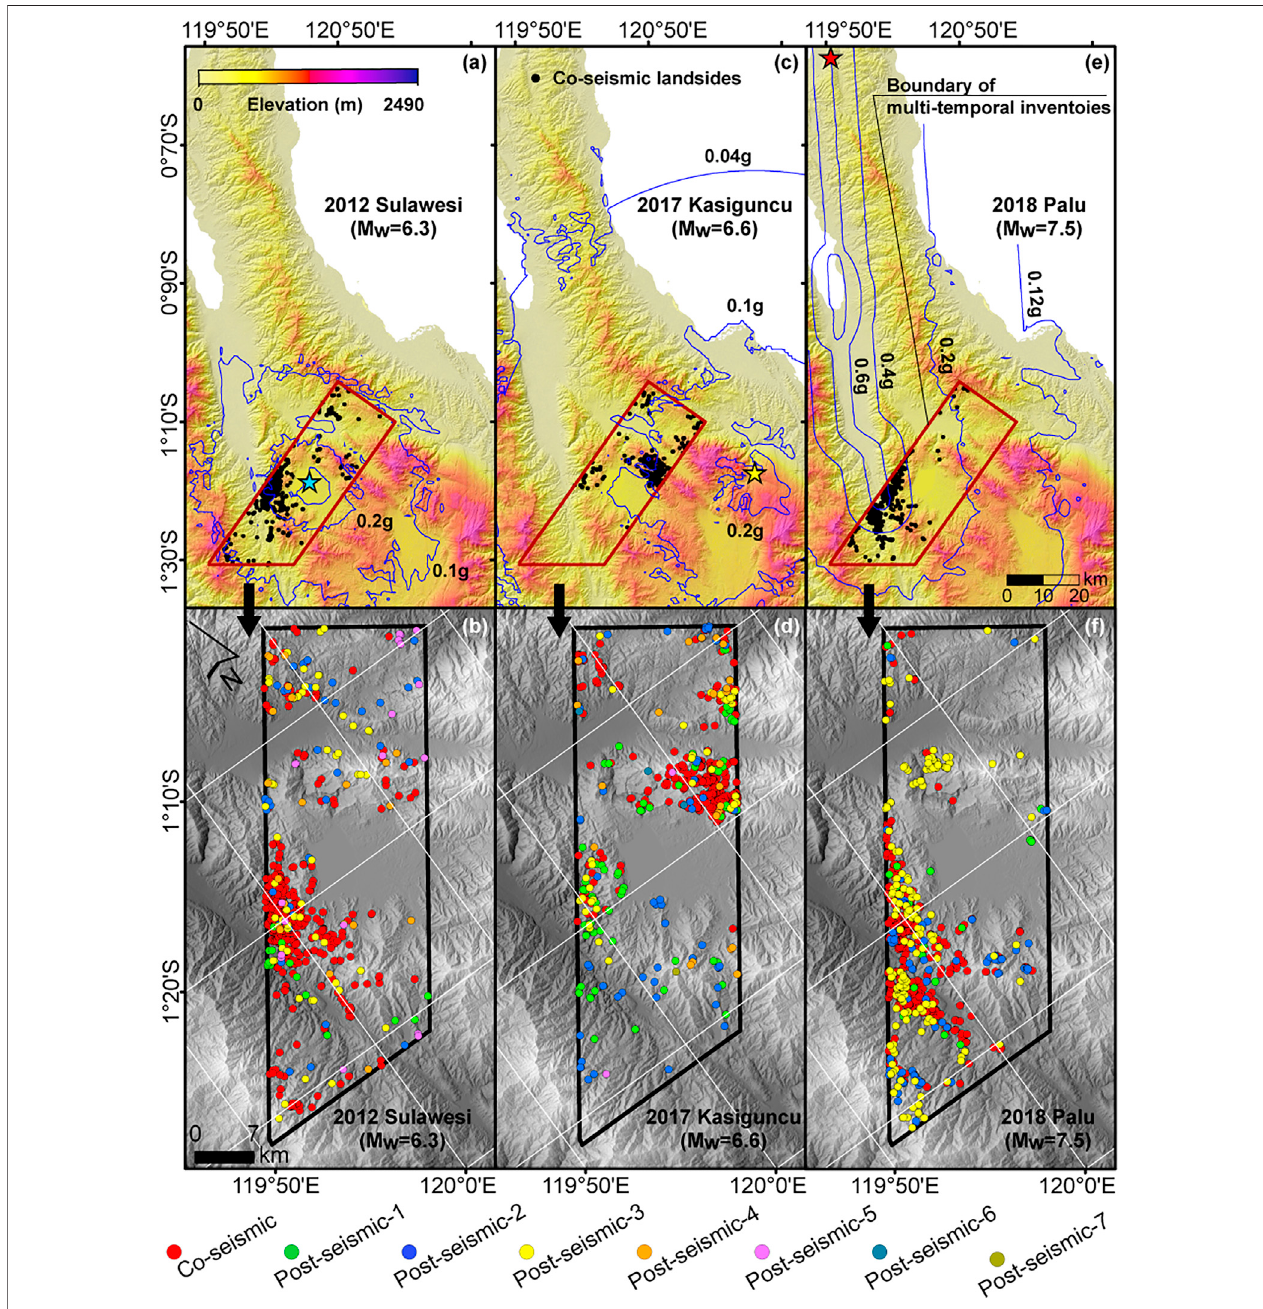
FIGURE4| Mapsshowingarealextentoftheexaminedareaandspatialdistributionoflandslideswemappedfor (A – B) 2012Sulawesi (C – D) 2017Kasiguncuand (E – F) 2018 Palu earthquakes. In Panels A , C and E blue contour lines show PGA values are acquired from the USGS ShakeMap system (Worden and Wald, 2016).